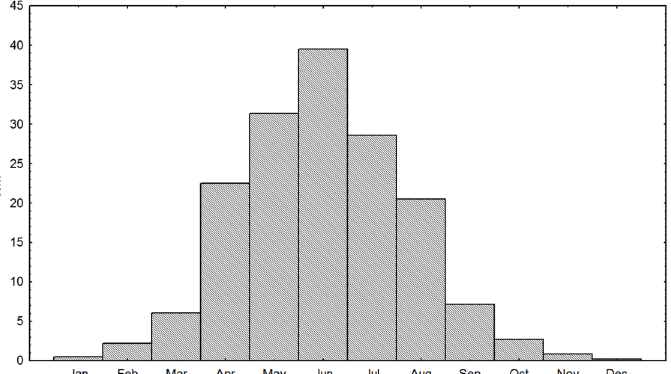
Figure 6. Monthly means of PAR (300–700 nm) cosine atmospheric irradiance incident upon the 300 m − 3